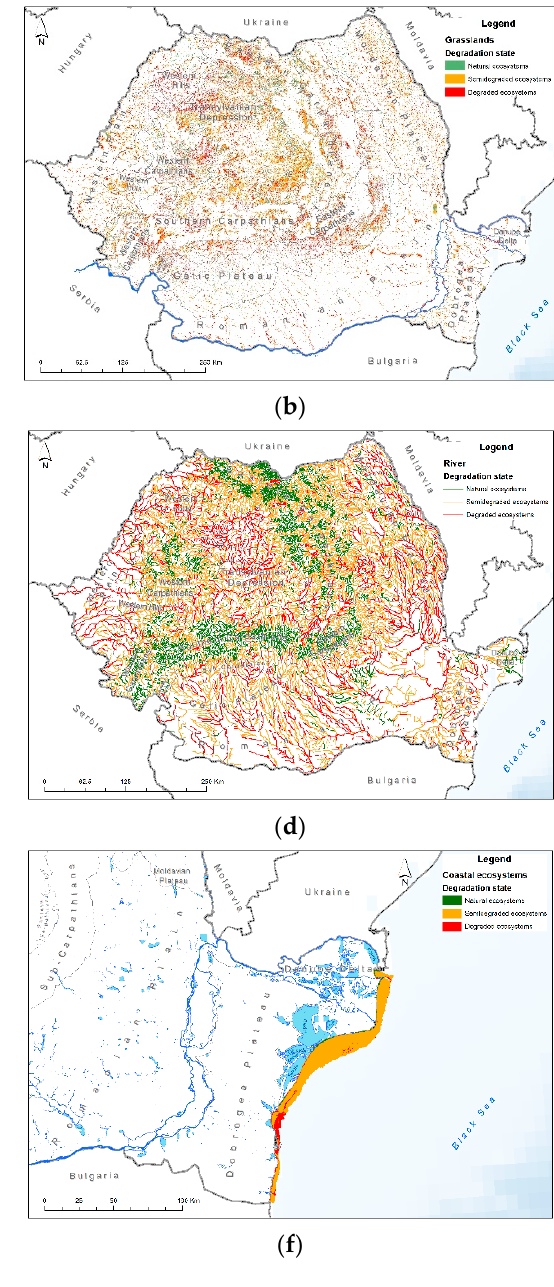
Figure 3. Distribution of ecosystems in Romania: ( a ) forest ecosystems; ( b ) grassland ecosystems; ( c ) cave ecosystems; ( d ) river ecosystems; ( e ) lake ecosystems; ( f ) coastal ecosystems. The grasslands cover the second largest ecosystem area within Romanian territory (Figure 3b). The largest degraded area of the grassland ecosystem was in the Transylva- nian Depression (approximately 2340 km 2 ), followed by the Eastern Carpathians with ap- proximately 2220 km 2 and the Sub-Carpathians with 1433 km 2 . Similar studies on grass- land degradation in the Sub-Carpathian area have drawn attention to the degradation rates of grassland in this area and the influence of this process in the manifestation of